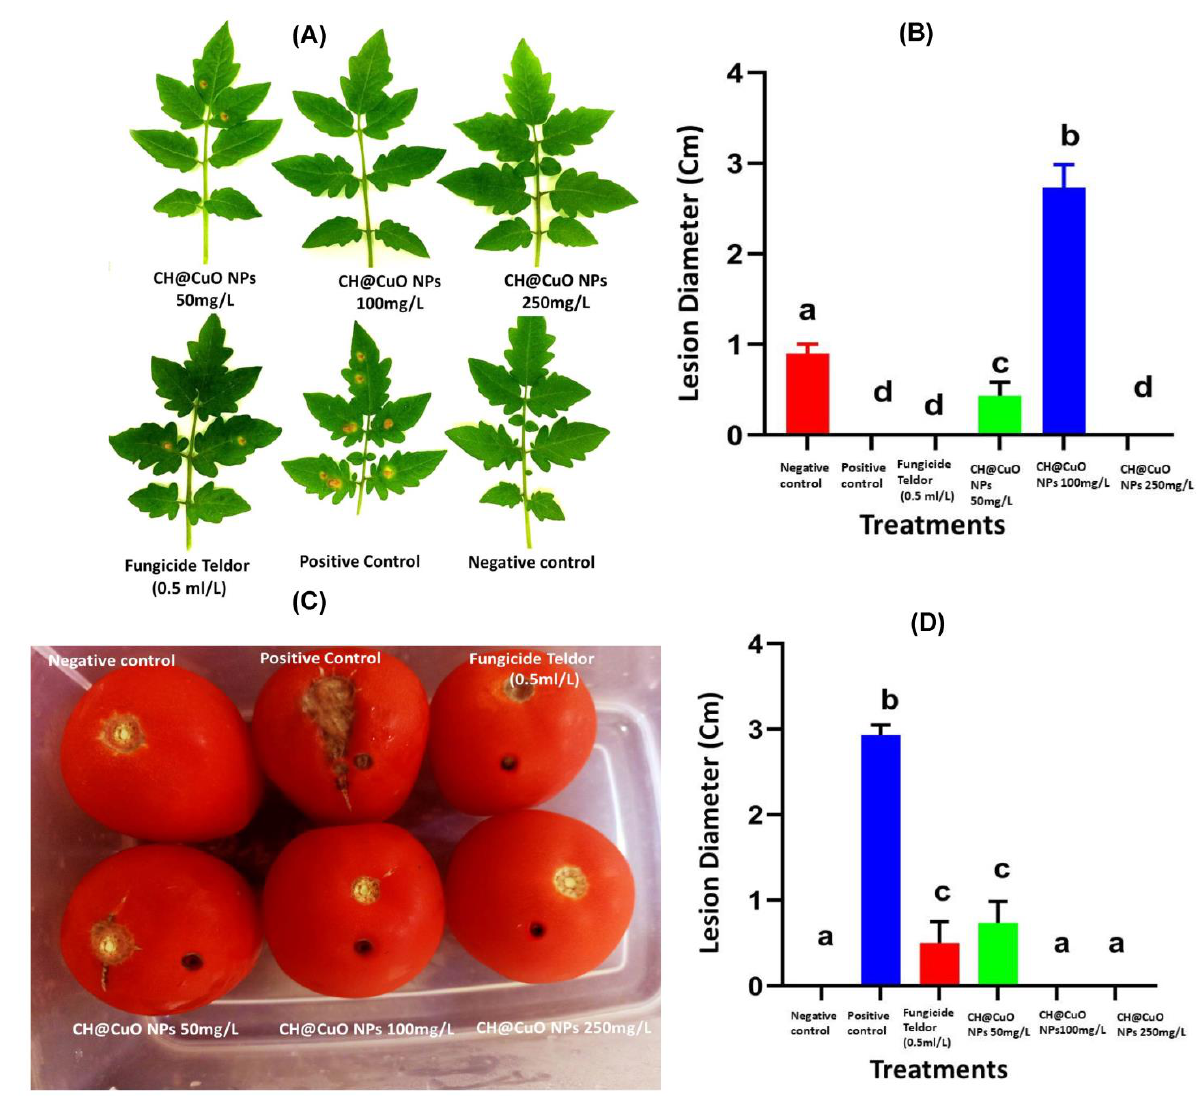
Figure 6. Effect of CH@CuO NPs on gray mold on tomato detached leaves treated with 50, 100 and 250 mg/L of CH@CuO NPs and fungicide (Teldor 50% SC.) ( A , B ); Effect of CH@CuO NPs on gray mold on tomato fruits, treated with 50, 100 and 250 mg/L of CH@CuO NPs and fungicide (Teldor 50% SC.) ( C , D ). Bars with the same letters are not statistically significant based on the LSD test ( p < 0.01).